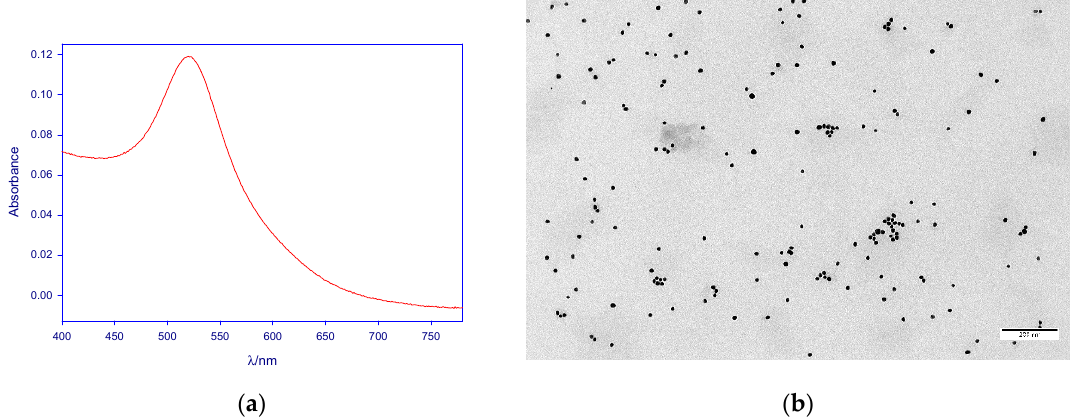
Figure 1. ( a ) Absorbance spectrum and ( b ) TEM imaging of the nanoparticle synthesis employed for working tests. Scale bar corresponds to 200 nm.